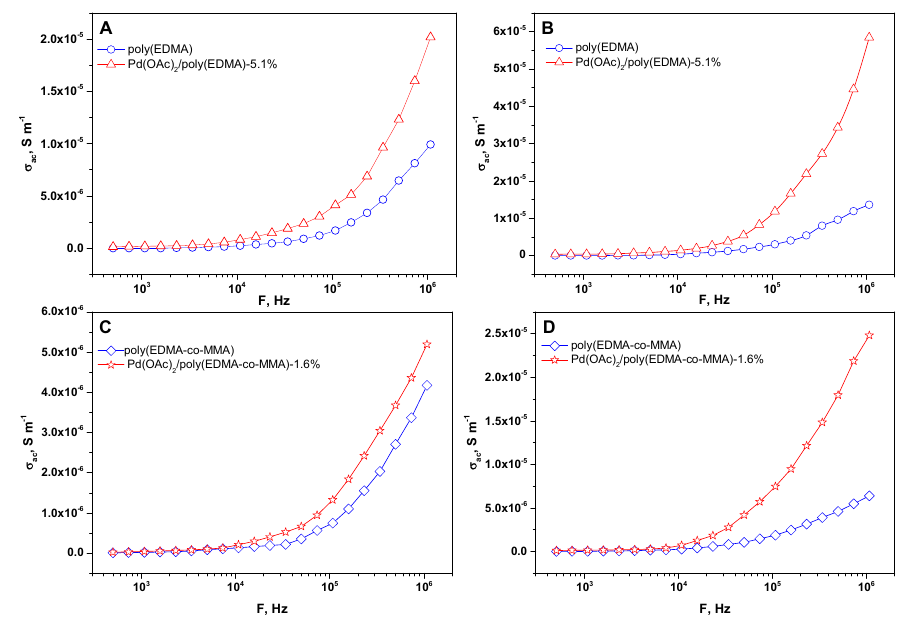
Figure 5. The effect of loading poly(EDMA) and poly(EDMA-co-MMA) with Pd(OAc) 2 on the AC conductivity at ( A , C ) 300 K and ( B , D ) 340 K.